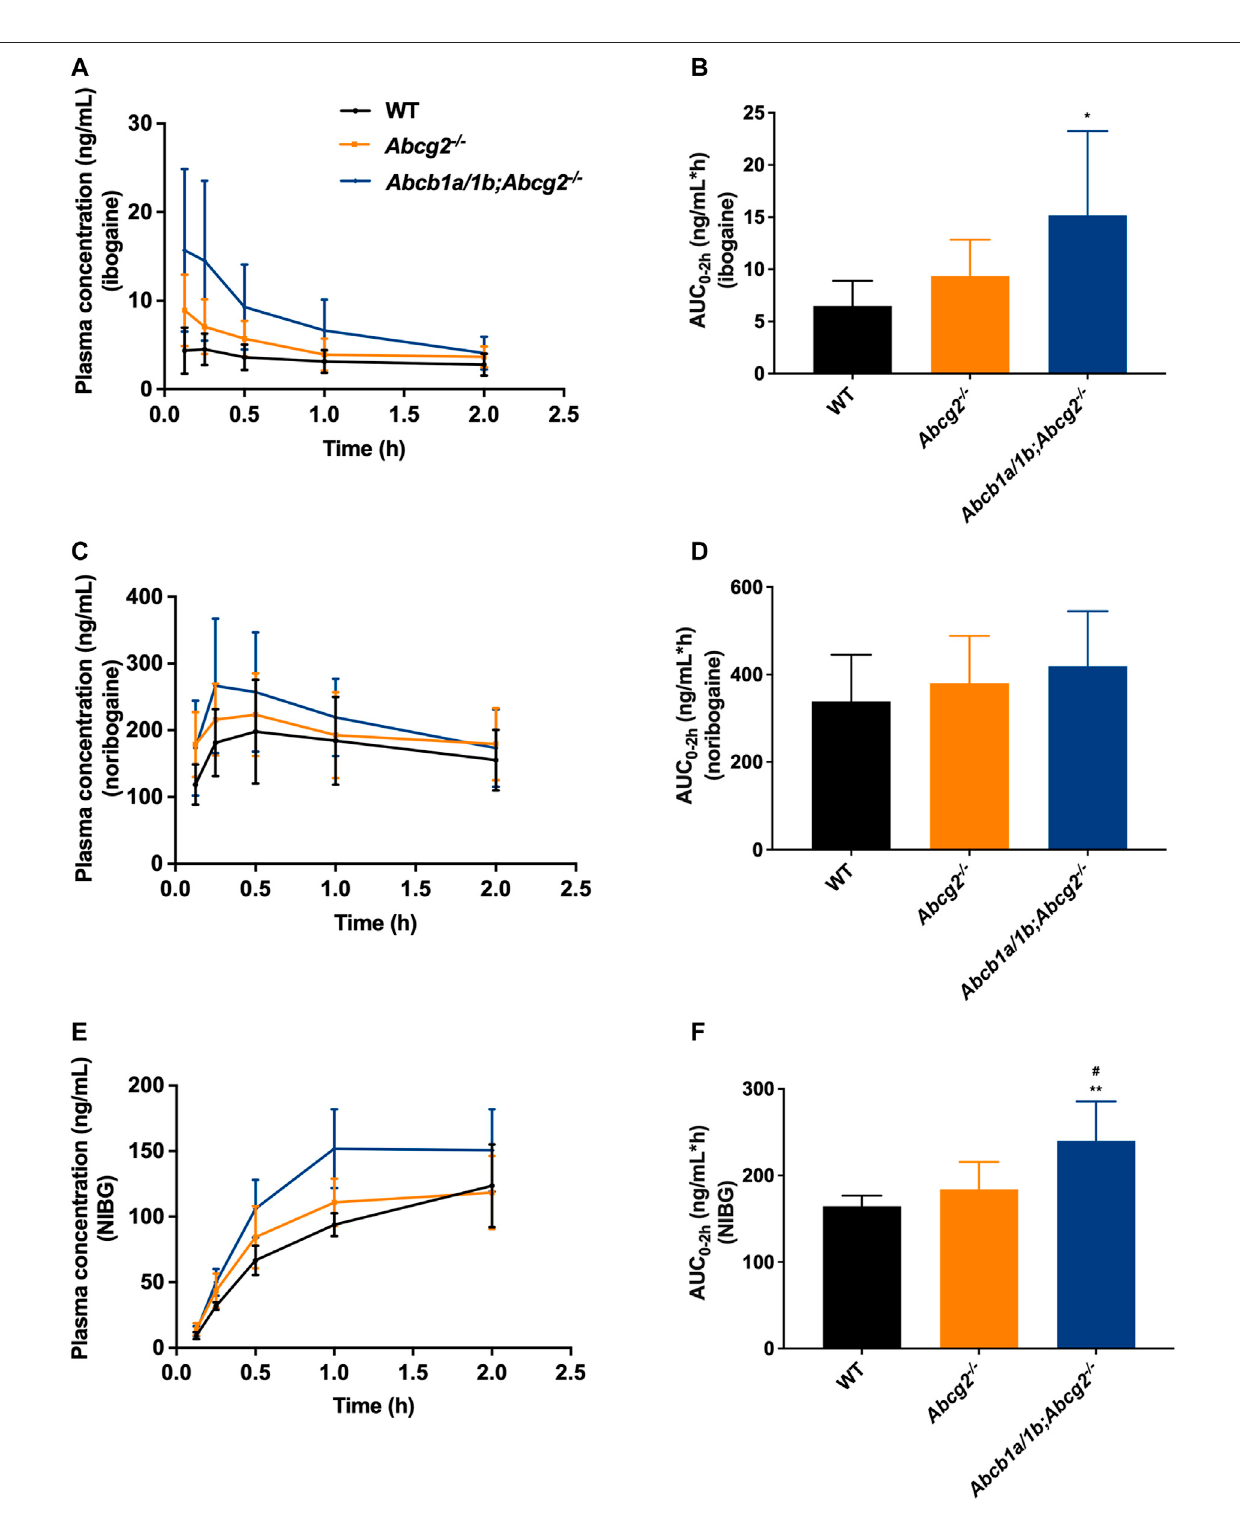
FIGURE 2| Plasma concentration-time curves and area under the plasma concentration-time curves (AUC) ofibogaine (A,B) , noribogaine (C,D) , and noribogaine glucuronide(NIBG) (E,F) ,respectively,infemalewild-type(WT), Abcg2 − / − ,and Abcb1a/1b;Abcg2 − / − mice,over2 hafteroraladministrationof10 mg/kgibogaine( n =7). Data are presented as mean ± SD. *, p < 0.05; **, p < 0.01 compared to wild-type mice; # , p < 0.05 comparing Abcb1a/1b;Abcg2 − / − with Abcg2 − / − mice.